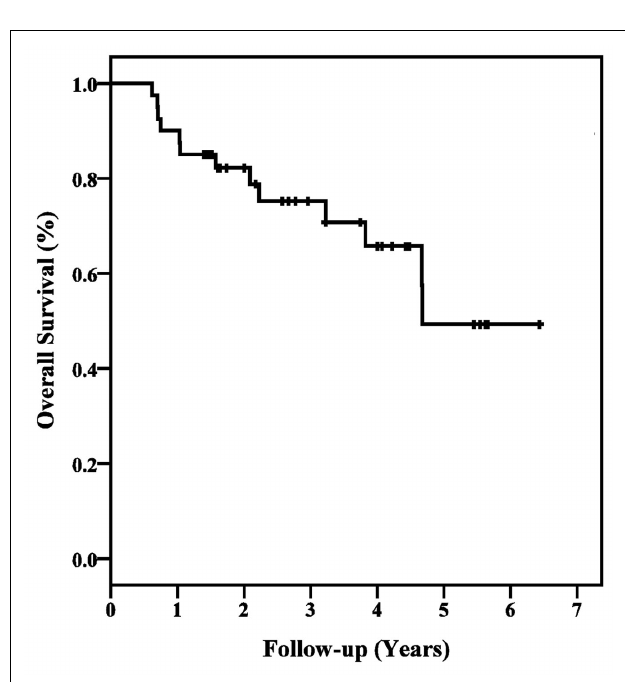
FIGURE 2 | Kaplan–Meier plot of overall survival.